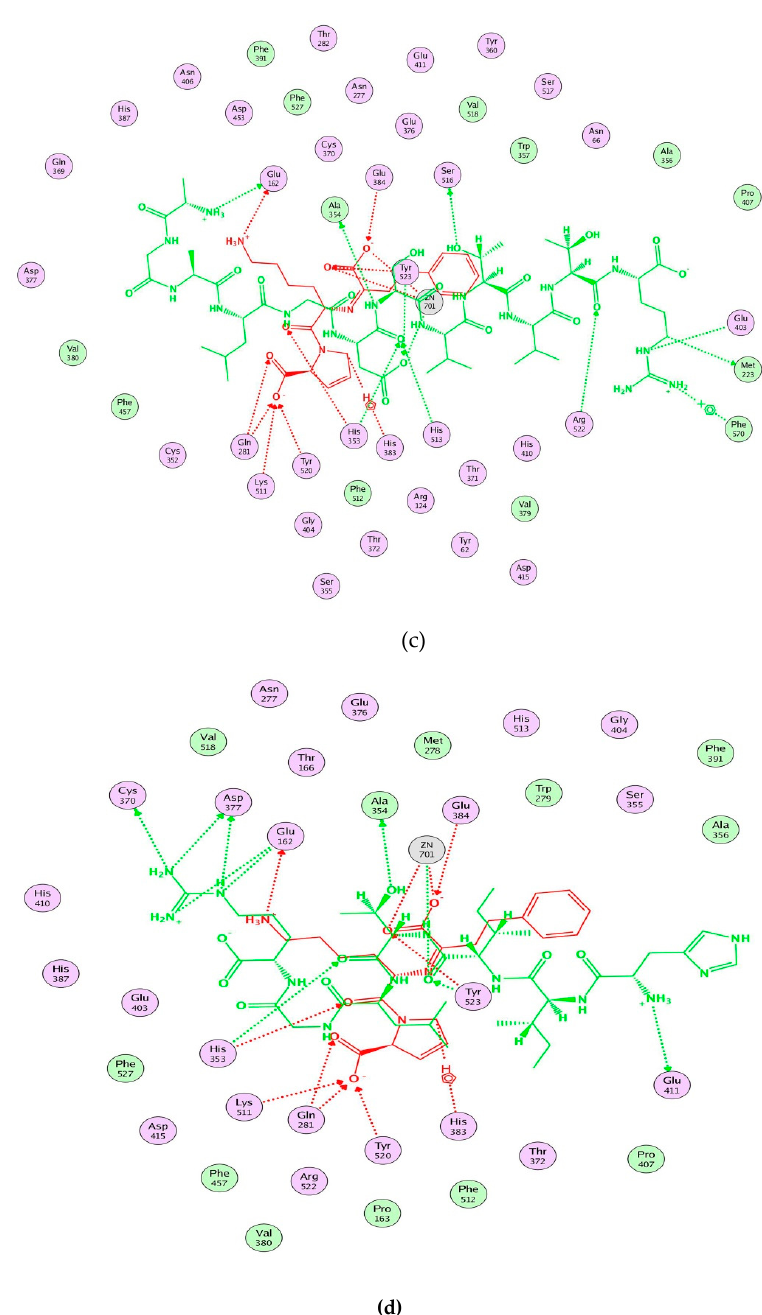
Figure 4. Molecular modeling of the interaction between inhibitors and ACE. ( a ) Molecular modeling of the interaction between lisinopril and ACE. ( b ) Molecular modeling of the interaction between GHIITVAR and ACE. ( c ) Molecular modeling of the interaction between AGALGDSVTVTR and ACE. ( d ) Molecular modeling of the interaction between HIITLGR and ACE. The ACE-lisinopril complex (1O86.pdb) was used as a template. The structure of lisinopril is in red and the peptides is in green. Hydrophobic, polar, and acidic residues of ACE are represented by green, violet, and red rings, respectively. Green and red arrows show hydrogen bonds from donor atom to acceptor.